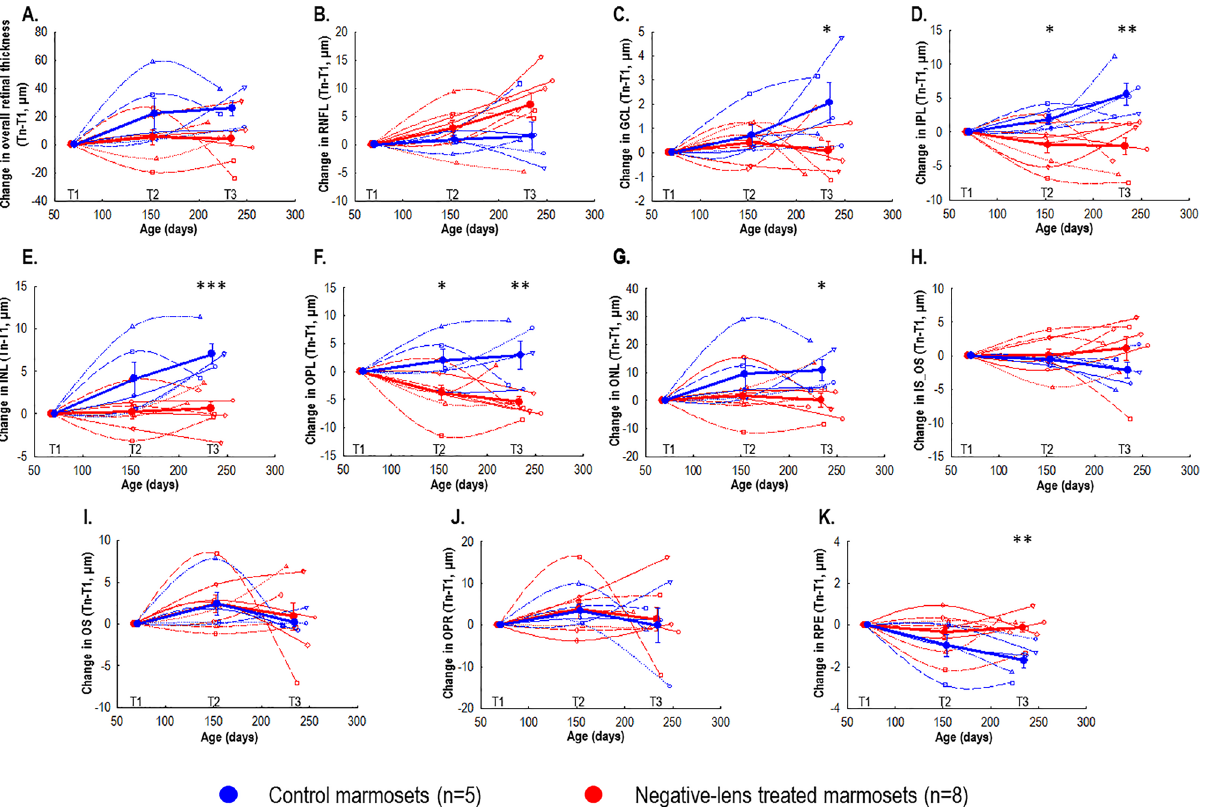
Figure 7. Change in mean overall retinal thickness ( A ) and the 10 individual retinal thickness layers ( B-K ) for control and negative-lens treated marmosets normalized to baseline over 22 weeks of treatment (T1: baseline, T2: 12 weeks of treatment, T3: 22 weeks of treatment). Thin symbols and lines represent data for each marmoset. Thick symbols and lines represent data for each treatment group. The untreated control group ( n = 5) is shown with blue circles, and the negative-lens treated group ( n = 8) is shown with red circles. Positive and negative values on the ordinate represent retinal thickening and thinning relative to baseline, respectively. Statistically significant difference at each treatment time point is indicated by * p < 0.05, ** p < 0.01 and *** p < 0.001. The data are shown as mean ±